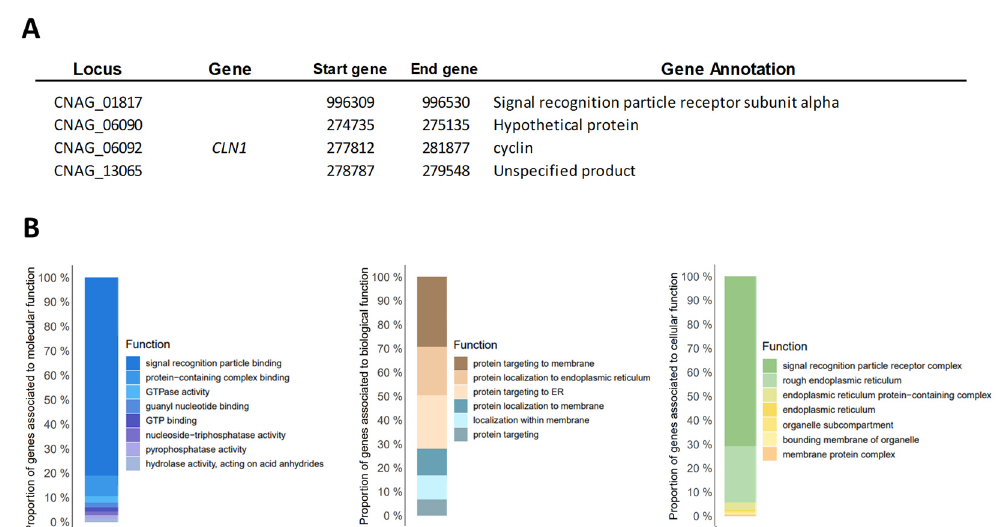
Figure 4. Evaluation of genes with copy number variation (CNV) shared between the 29 Colombian Cryptococcus neoformans genomes. ( A ) The genes with CNV were shared between the 29 isolates included in the study. ( B ) Gene Ontology enrichment analysis to functional categories (molecular, biological, and cellular).